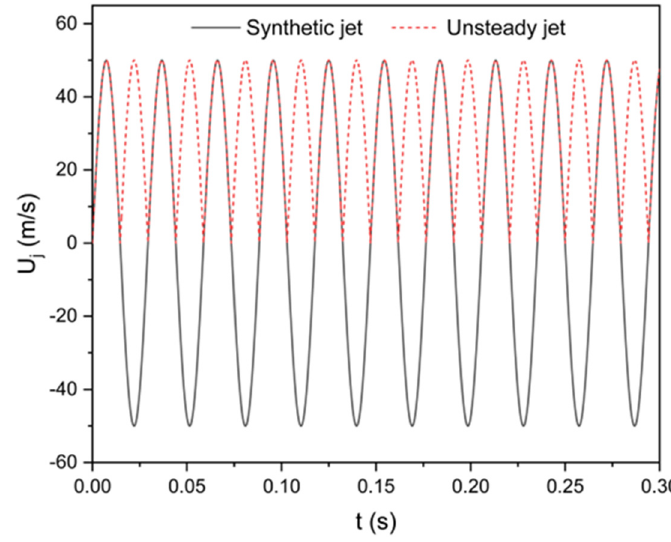
Figure 8. Output signals of synthetic and unsteady jet devices.